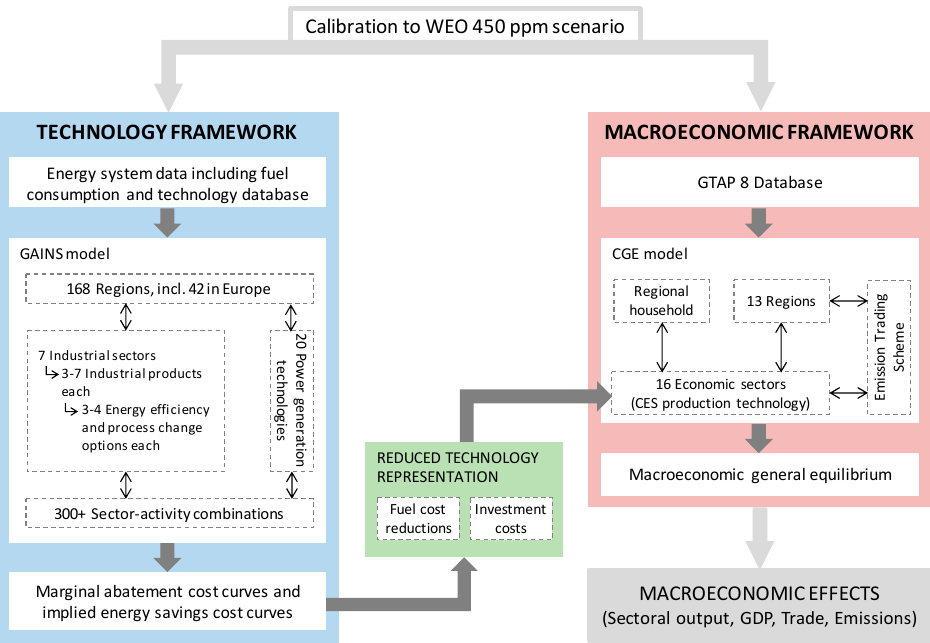
Figure 1. Methodological approach of GAINS technology model and macroeconomic CGE model linking.